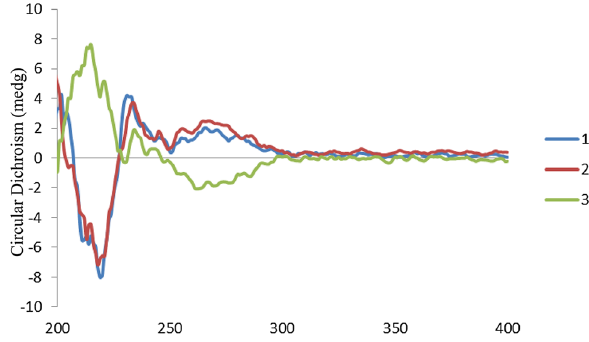
Fig. 3 ECD spectra of compounds